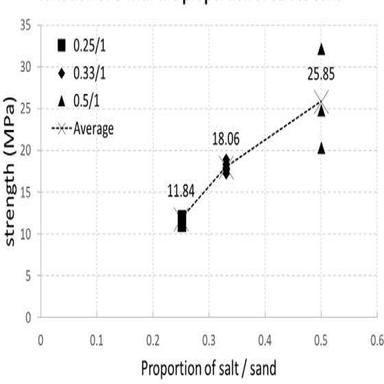
Variation of compressive strength with different proportion of salt to sand.